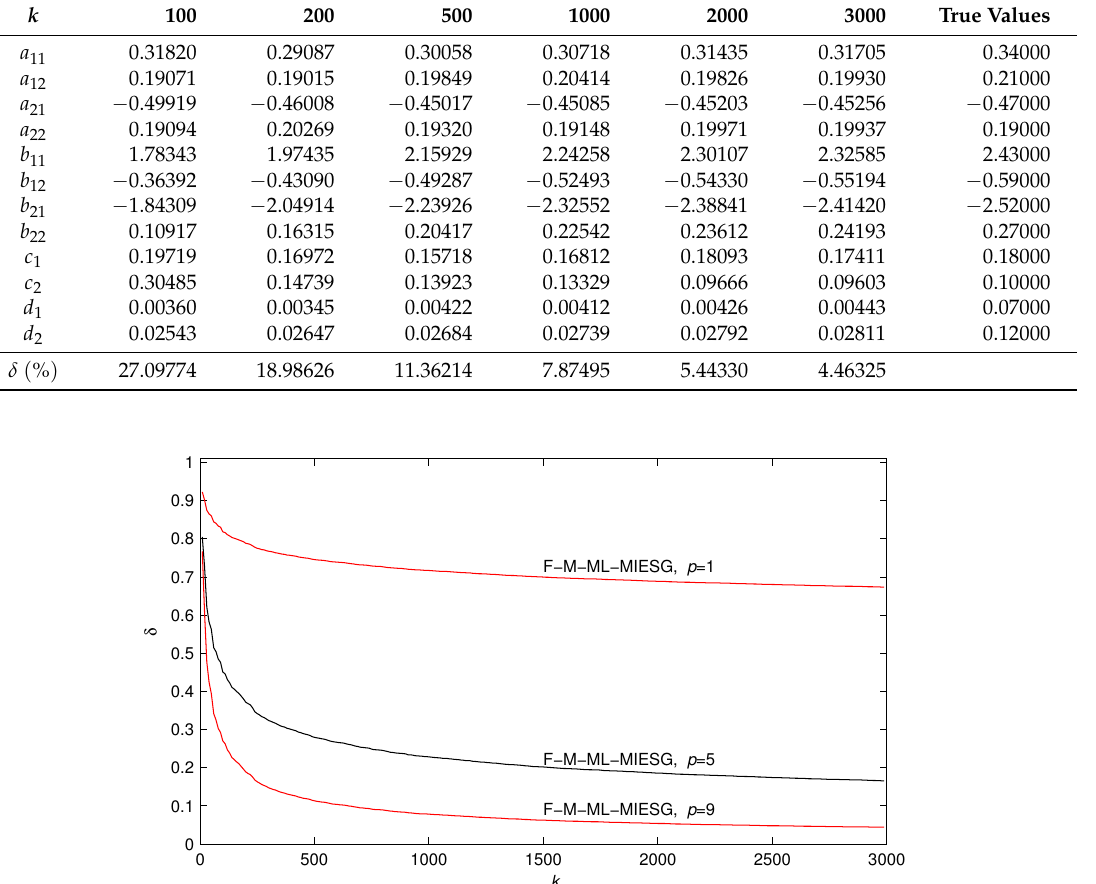
Table 1. The F-M-ML-MIESG estimates and errors ( σ 2 = 0.10 2 , p = 9).